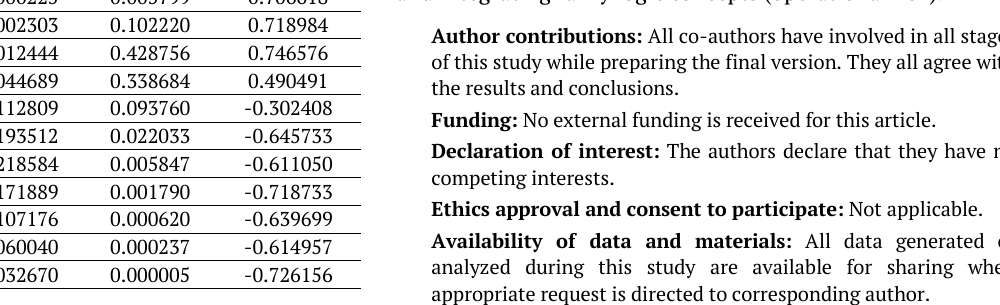
Table 6. Radar Chart Structure – Impact COVID-19 (USA) Sentiment